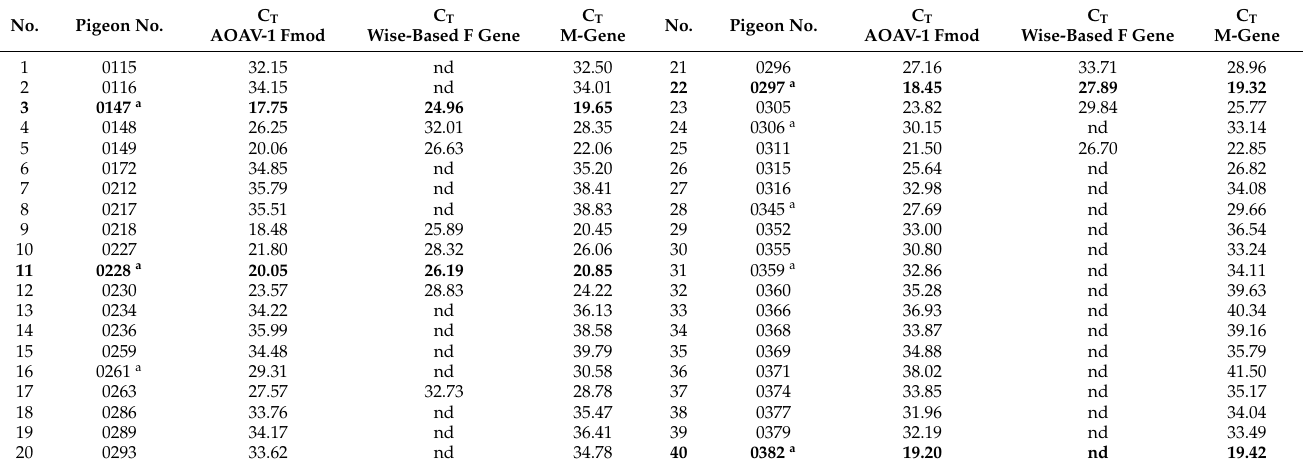
Table 4. Clinical samples of feral pigeons. RNA extracted from kidney previously tested positive for the AOAV-1 M-gene [3] was tested with the AOAV-1 F gene and the Wise-based F gene assay. C T : threshold cycle value, nd: not